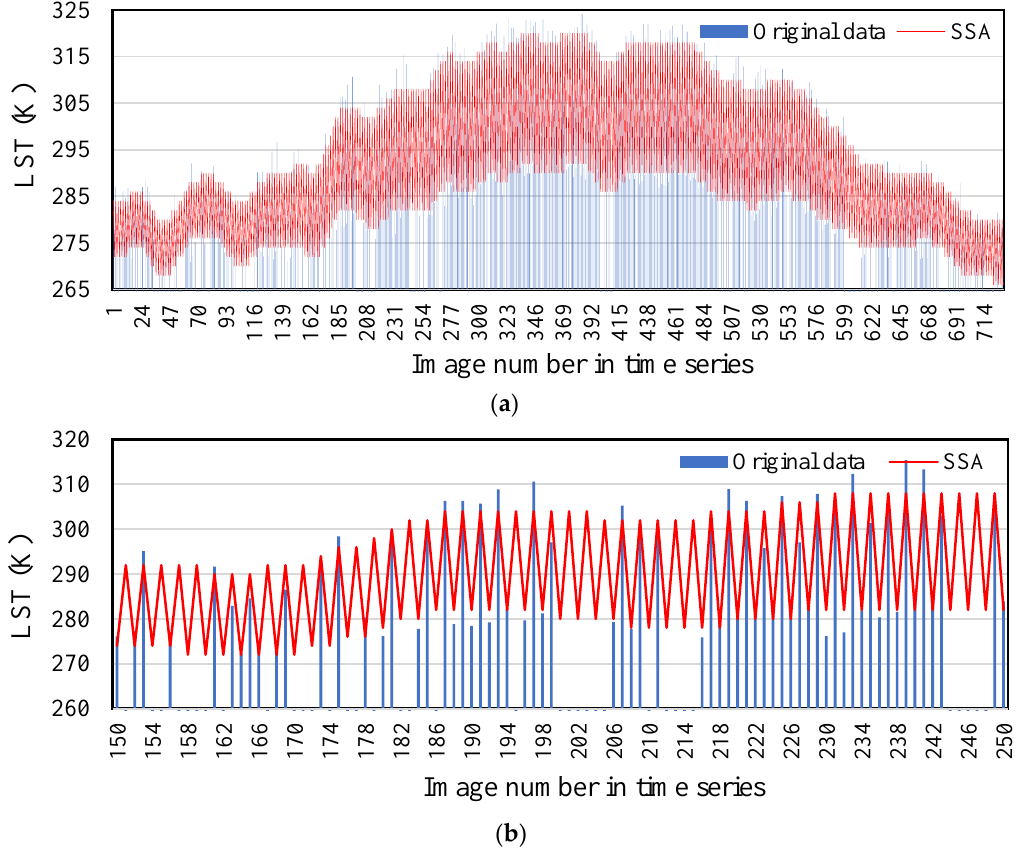
Figure 13. A time series along a pixel together with the reconstruction results of SSA ( a ) and the magnification of a part of a time series ( b ).